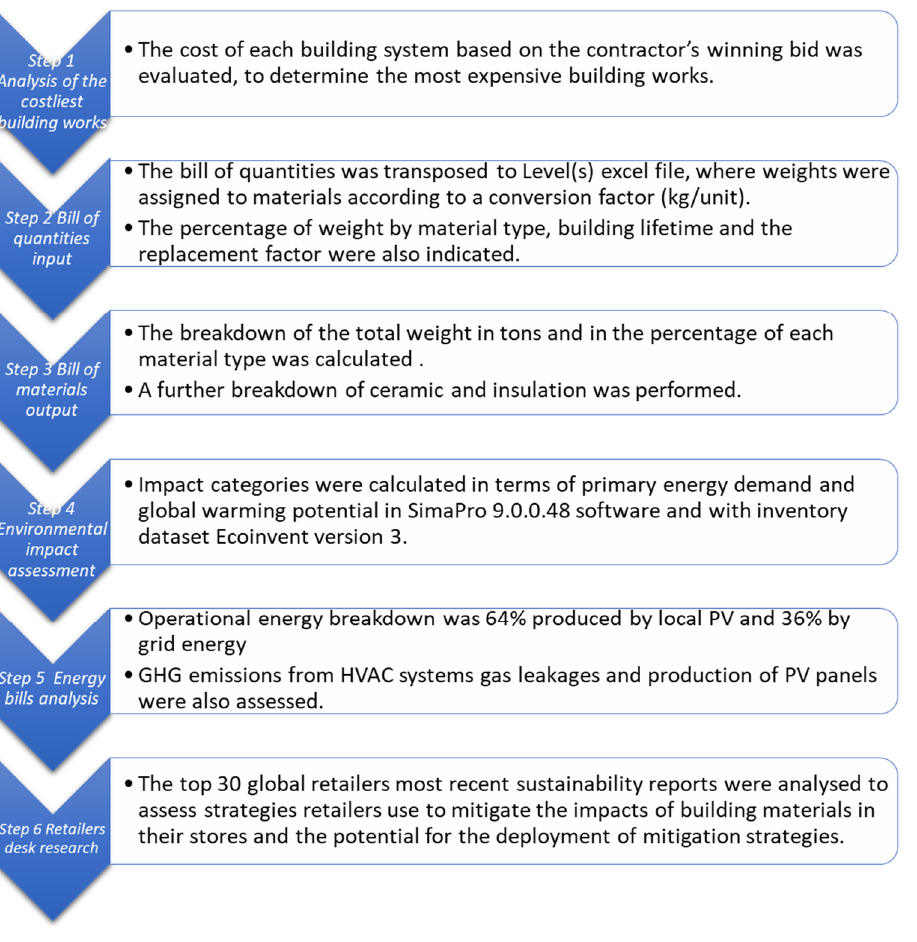
Figure 6. Cost disaggregation by the percentage of the cost of building system for the case study store.